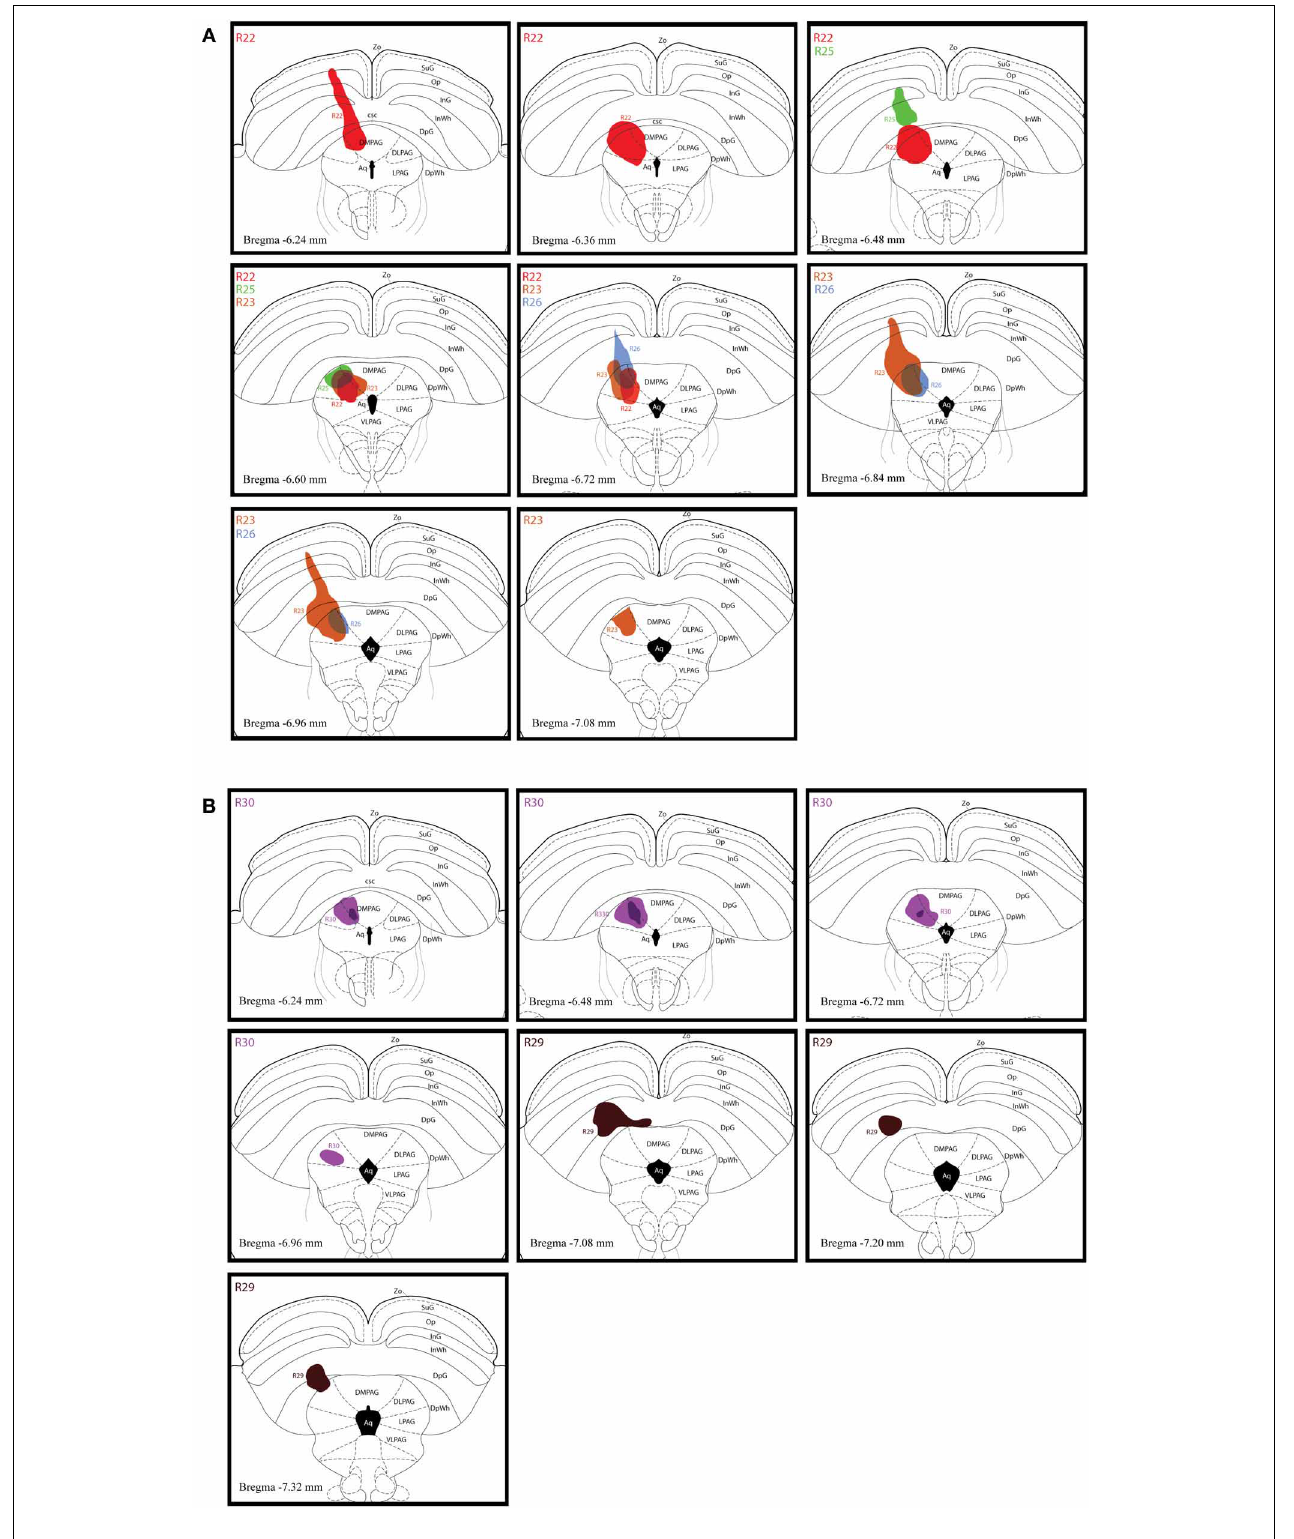
FIGURE 2 | Injection sites of retrograde tracer experiments. (A) Schematic drawings representing CTb deposits by pressure injections along the rostro-caudal extent of the dlPAG and the SC. The four cases are represented by different colors (R22 in red, R23 in brown, R25 in green and